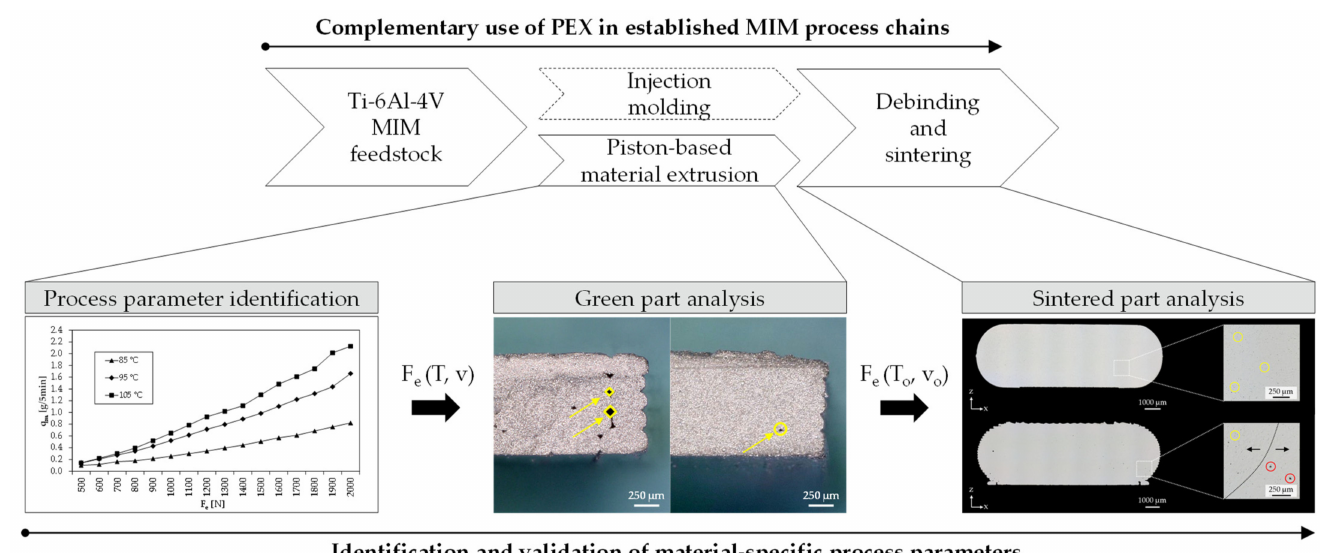
Figure 7. Methodical approach for identification and validation of materials-specific process parame- ters for a complementary use of PEX in already established MIM process